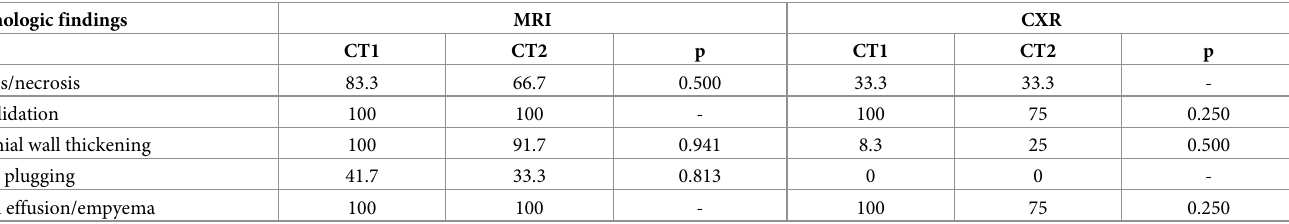
airways then on other morphological findings. Table 6. Prevalence of findings in MRI and CXR at